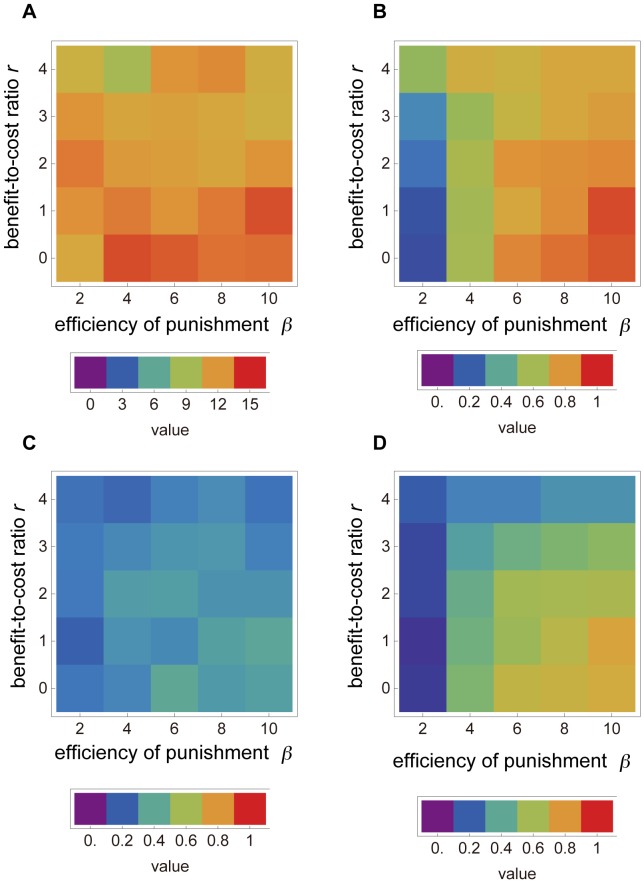
Effects of parameters on evolution in the spatially structured condition.The horizontal and vertical axes represent the effectiveness of public goods (r) and punishment (β), respectively. Each data block is the average of 50 trials. (A), (B), (C), and (D) represent the average values of a (strictness), x (cooperation level), f (punishment level), and u (punishment threshold) at 1,000,000 generations, respectively. Deeper color means that the trait evolved to a higher value. Each bar below each graph presents the relationship between a value and color.